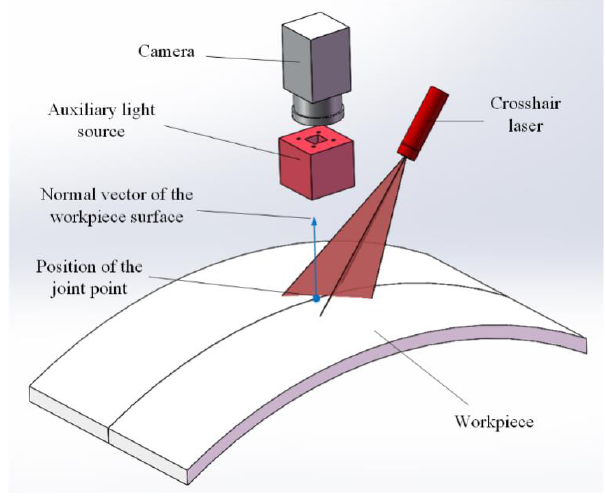
Figure 1. Basic experimental setup of the proposed method.